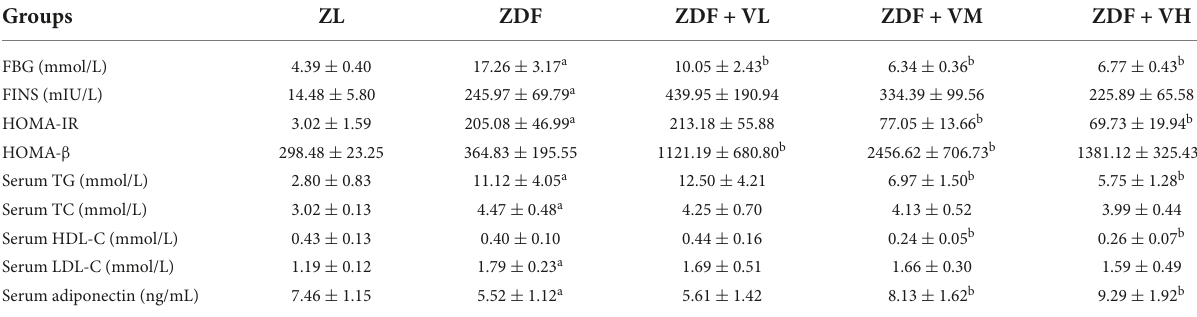
TABLE 1 Effects of 1,25(OH) 2 D 3 on insulin sensitivity and parameters of lipid metabolism in Zucker